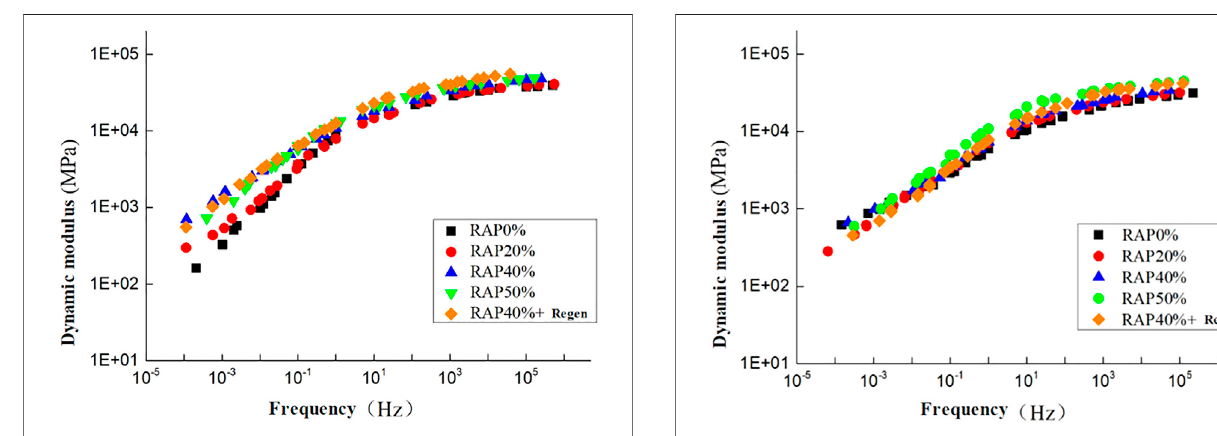
FIGURE 2 | Master curve of fi ve different AC-20 normal asphalt recycled mixes.